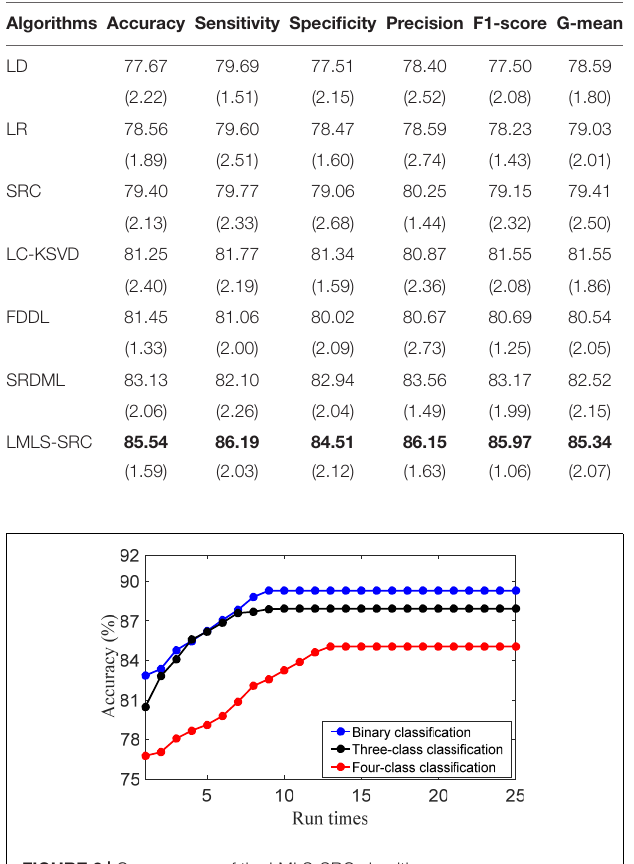
FIGURE 2 | Convergence of the LMLS-SRC algorithm.